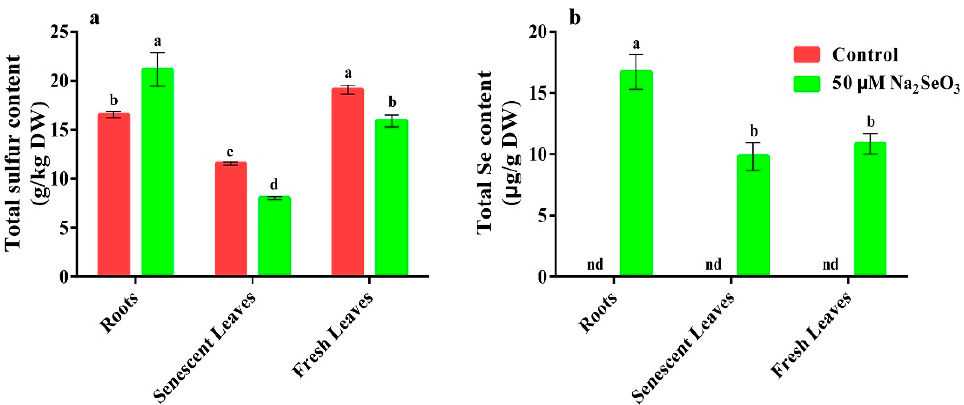
Figure 1. Effect of Se on total sulfur and total Se contents. ( a ) Total sulfur content in different tissues of young broccoli plants under control and 50 μ M Na 2 SeO 3 treatments. ( b ) Total Se content in different tissues of broccoli under control and 50 μ M Na 2 SeO 3 treatments. Each value represents mean ±SD (the same below). Data with different lower-case are significantly different at p < 0.05.